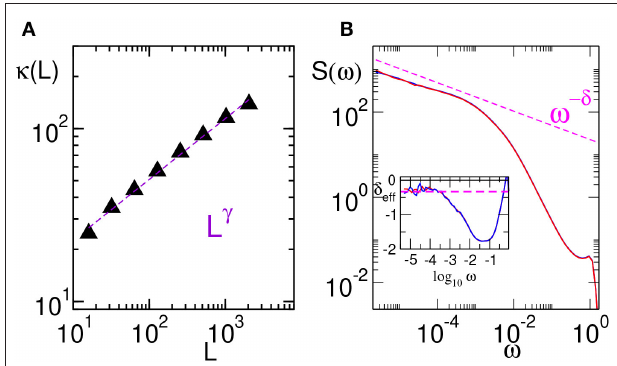
FIGURE 1 | Anomalous thermal conductivity for the FPUT model with cubic and quartic potential terms ( α 0.25, β 1): (A) finite-size conductivity = = measured in the non-equilibrium steady state; (B) power spectrum S ( ω ) of J ( t ) J (0) heat current fluctuations [i.e., the Fourier transform of ]. The long-time h i tail in (2) corresponds to a divergence ω − δ at small frequencies. The inset of d log 10 S / d log 10 ω . The data are (B) displays the logarithmic derivative δ eff = γ compatible with δ 1 / 3 (dashed lines). Microcanonical simulations are = = performed at energy density